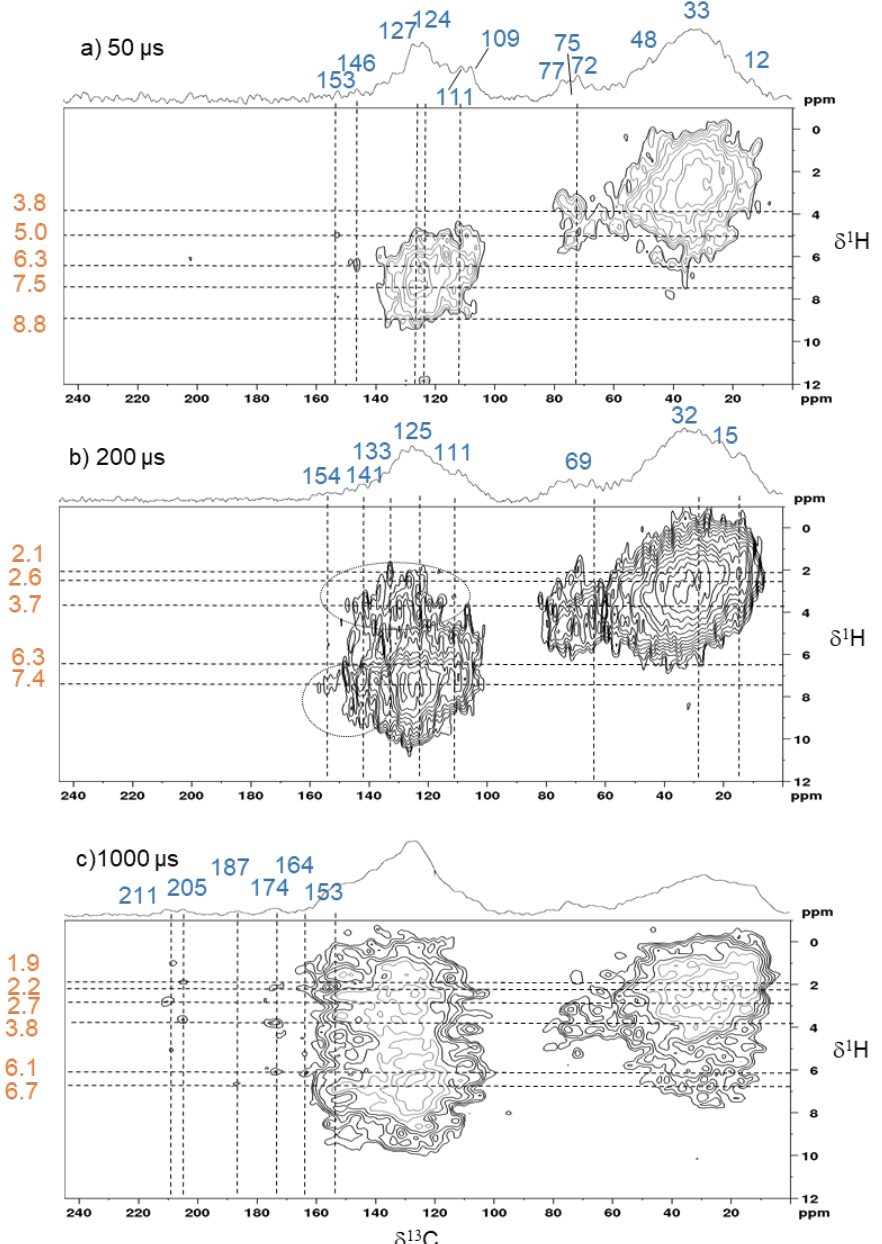
Figure 5. Solid-state 2D 1 H- 13 C HETCOR NMR spectra from cellulose charred at 350 ◦ C for 1 h obtained with t c = 50 µ s ( a ), 200 µ s ( b ) and 1000 µ s ( c ). Lines indicate the chemical shifts of selected cross peaks. 13 C and 1 H chemical shifts of cross peaks are given in blue and orange, respectively. Cross peaks are visible in the chemical shift region of O -alkyl C/H ( δ C/ δ H 77 to 64 ppm/3 to 5 ppm). The 13 C signals around 75 ppm were previously interpreted as deriving from residual or “final” carbohydrates. The latter were suggested to be intermediates, formed during heating up to 325 °C and converting into aromatic structures at higher